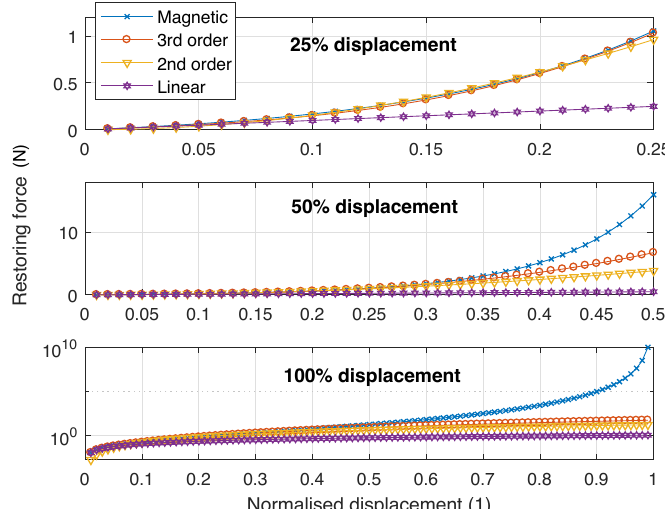
Figure 3. Restoring force of various orders of spring mechanisms. While a second order spring such as a pneumatic system or a third order spring such as a Duffing-type system offers relatively the same restoring force within a small displacement ( ∼ 25%), the magnetic spring has a significantly higher nonlinear restoring force at a larger displacement level. Therefore, magnetic springs can serve as a more effective suspension mechanism for large vibration